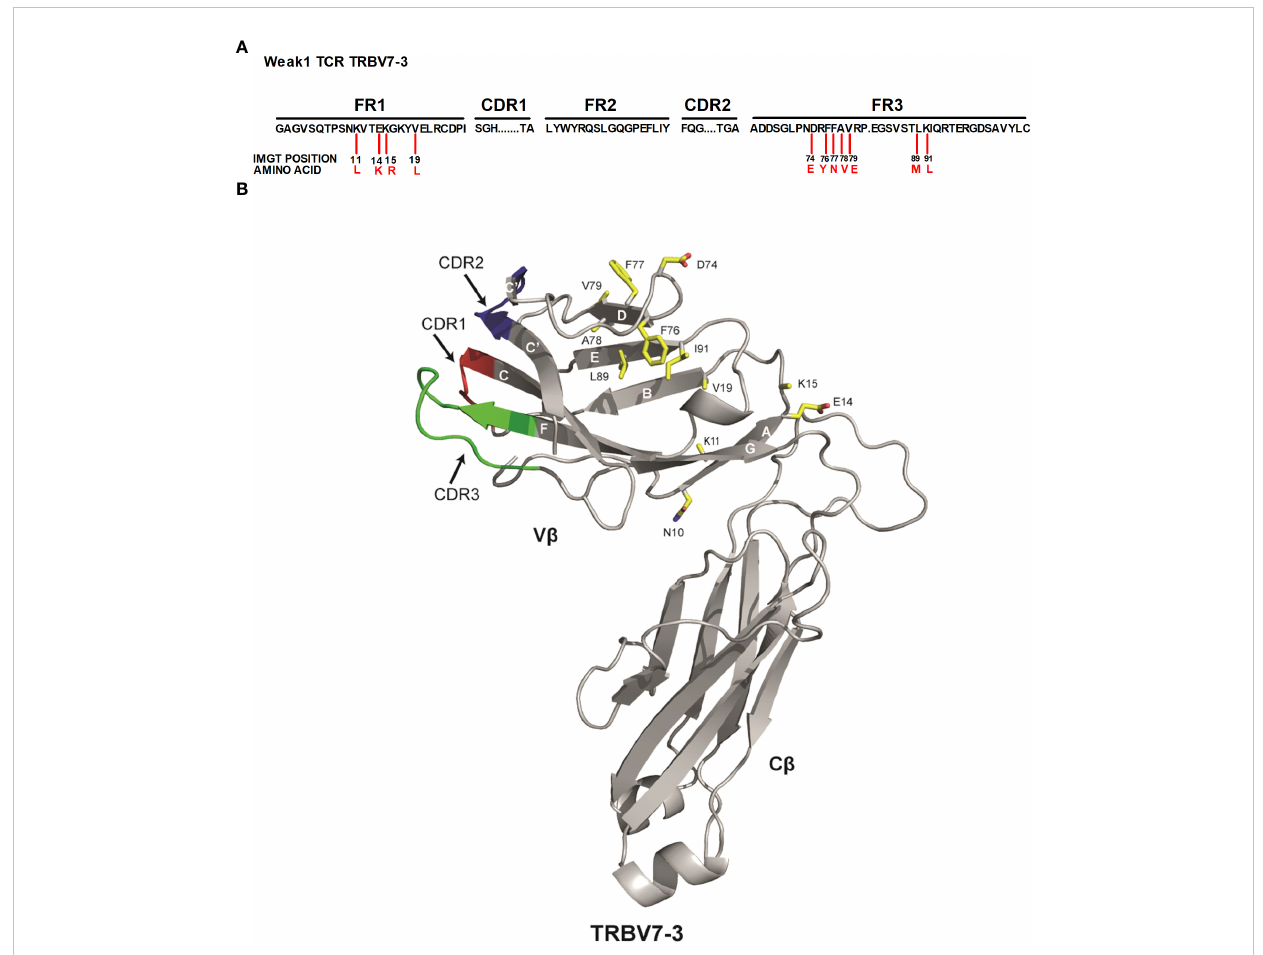
FIGURE 1 Identi fi ed 11 TRBV framework residues are distal to the CDR parts (A) Representation of the candidate residues assessed. Numbers in black indicate the IMGT positions in the TCR b framework regions that were substituted with the amino acids indicated in red. FR framework region, CDR complementarity determining region. (B) The published 3-D structure of the 3PL6 TCR (TRAV13-1/TRBV7-3) was used as a model for the weak 1 TCR (TRAV13-2/TRBV7-3) used in this study. The location of each of the 11 residues that were changed in the weak 1 TCR V b domain to enhance TCR surface expression is indicated. Also included is location of residue at position